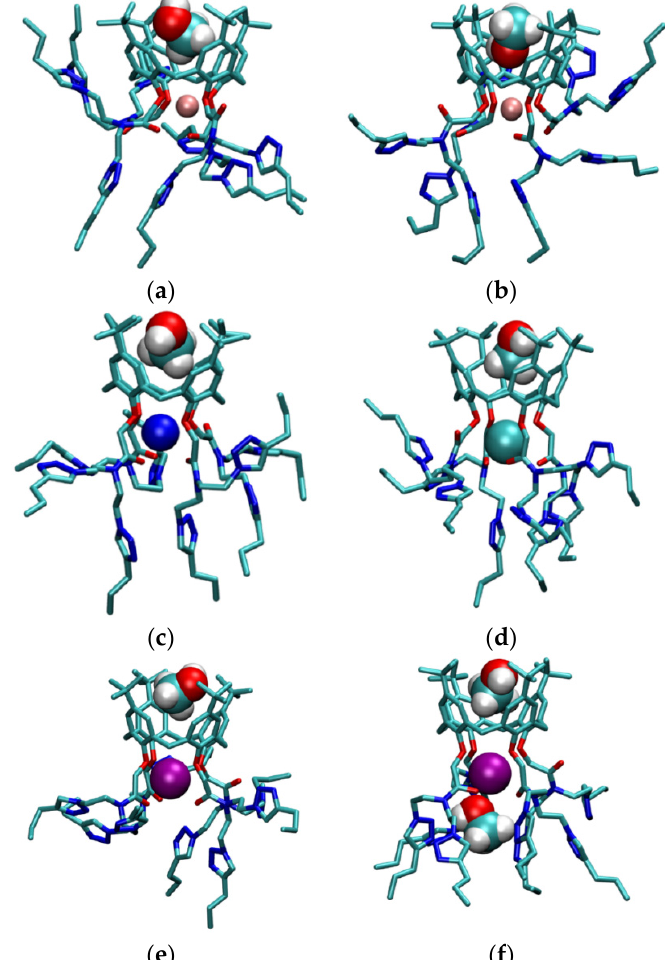
Figure 8. Structures of ( a ) Li L MeOH + ; ( b ) Li L MeOH' + ; ( c ) Na L MeOH + ; ( d ) K L MeOH + ; ( e ) Rb L MeOH + ; and ( f ) Rb L( MeOH) 2+ complexes obtained by MD simulations at 25 °C. Hydrogen atoms of L are omitted for clarity.